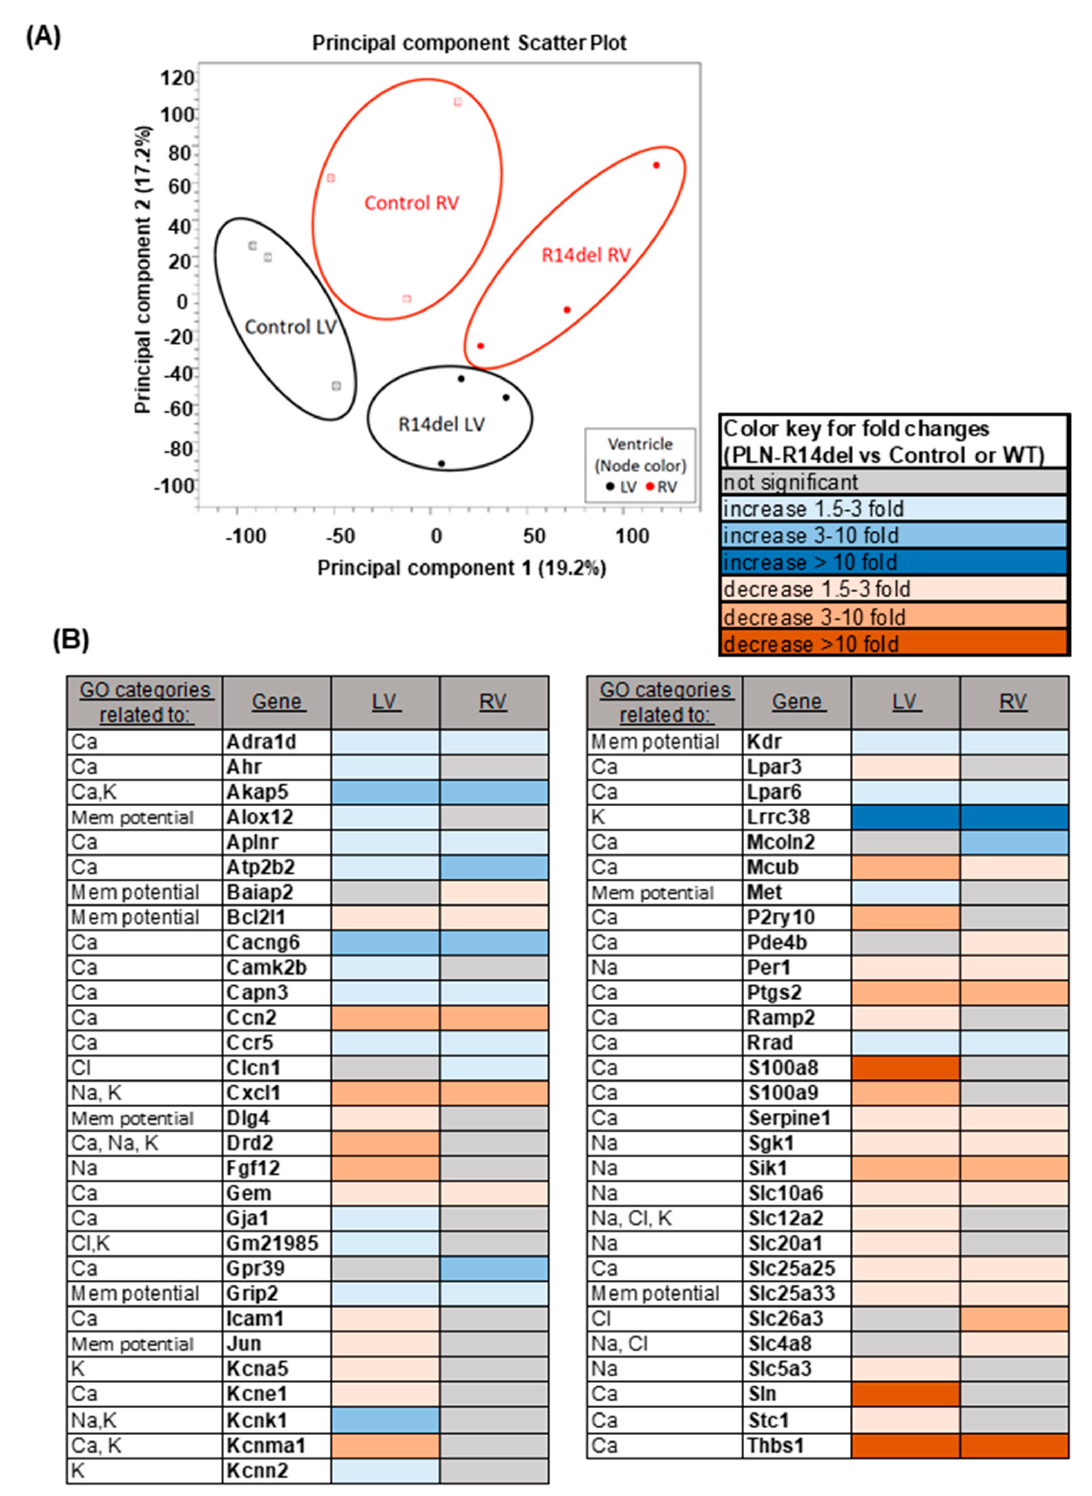
Figure 9. Identification of R14del-PLN Mutation Changes in Electrophysiological and Ca Cycling Transcript Levels. ( A ) The principal component analysis is based on normalized expression values for RNA seq data for the RV and LV of R14-PLN and Control or WT-PLN mice (N = 3). ( B ) Significantly changed Gene Ontology categories ( p ≤ 0.05) related to membrane potential and ion homeostasis changes, based on the analysis of the significantly changed genes (FDR-corrected p -value ≤ 0.05 and fold ≥ |1.5|) detected between PLN-R14del LV and WT (Control) LV, or PLN-R14del RV and WT (Control) RV. The table includes the gene symbol and level of fold change in the LV and RV, based on the provided color key.